Question: Summarize what this figure shows in one sentence.
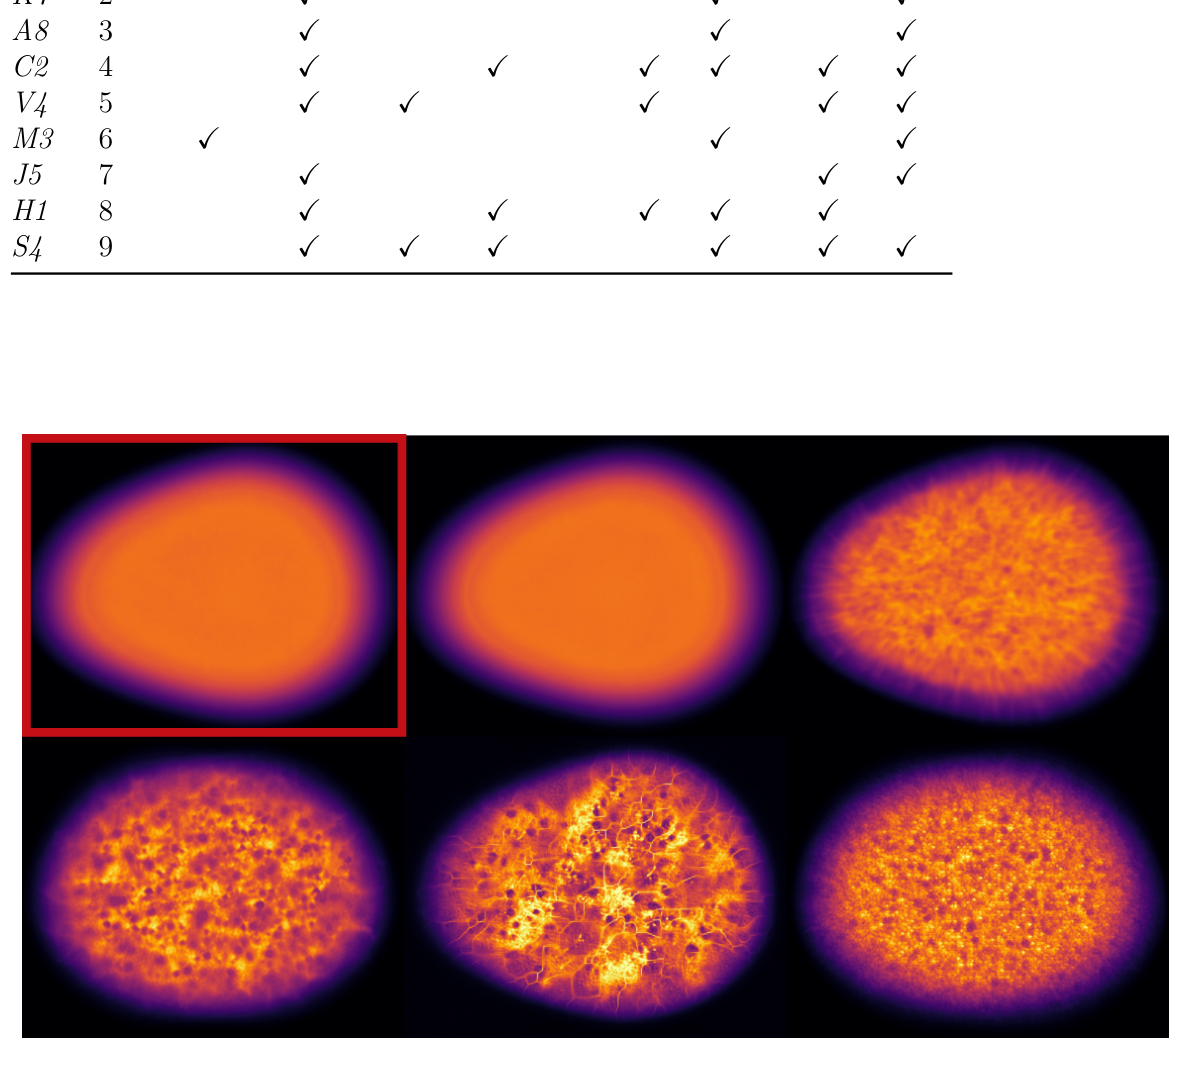
Answer: Ensemble mean images over 10000 randomly selected slices from the training data (highlighted in red), and five submissions ranked 1, 2 (row 1, center, and right), 4, 5, and 8 (row 2, left to right), demonstrate positional preference in tissue locations. Distinct structure within the breast region is clearly visible in all except the first-ranked submission, and is indicative of pixel-specific bias in tissue generation.